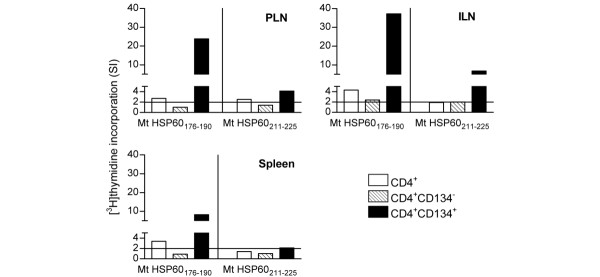
CD134+ T cells recognize the disease-associated mycobacterial epitope early in adjuvant arthritis. Popliteal lymph nodes, inguinal lymph nodes, and spleens were isolated from n = 13 rats at day 10 after immunization with Mycobacterium tuberculosis (Mt). The organs were pooled by organ type, and single-cell suspensions were stained for CD4 and CD134. The cells were sorted into CD4+ (white bars), CD4+CD134- (hatched bars), and CD4+CD134+ (black bars) fractions. Proliferative responses to 20 μg/ml Mt HSP60176–190 (in which HSP60 stands for heat shock protein 60) were tested in a [3H]thymidine incorporation assay. As a control, the proliferation in response to 20 μg/ml Mt HSP60211–225 (not related to disease) was tested. Results are expressed as the mean SI of triplicate wells. The cut-off value for proliferation was set at SI = 2 (indicated by the horizontal line). Shown is one representative experiment of three.